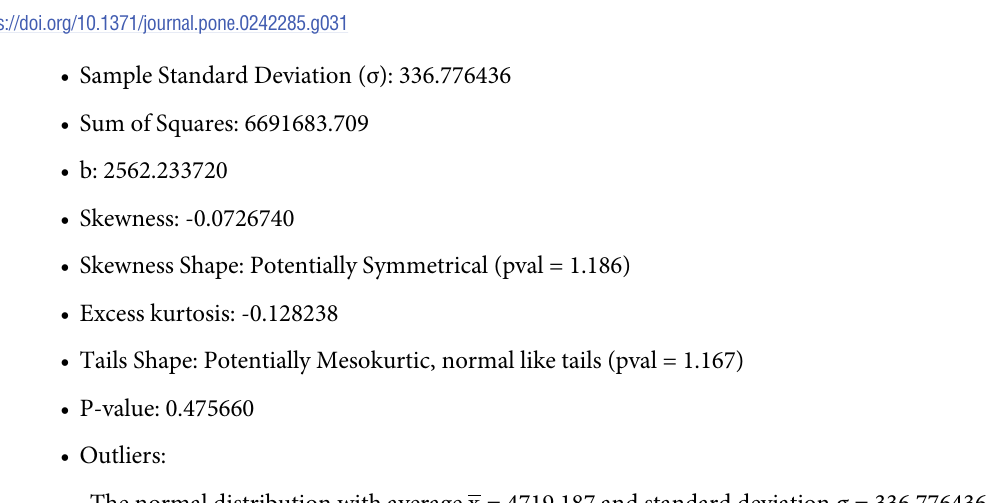
Fig 31. Histogram for the initial tour cost in the QA method.